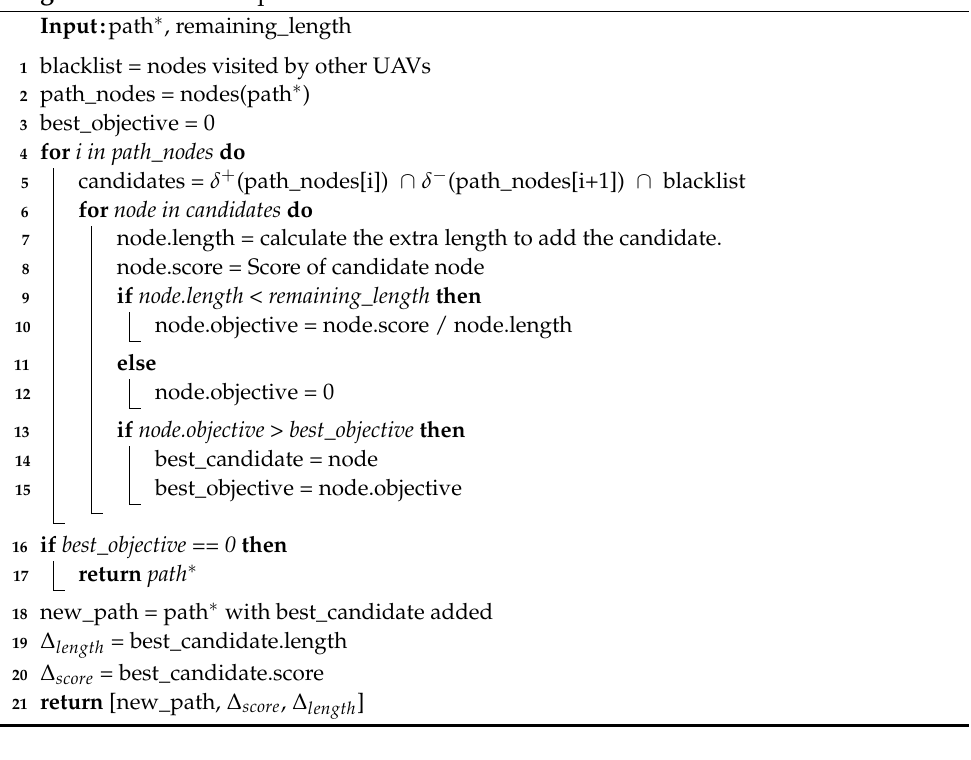
Algorithm A3: Add